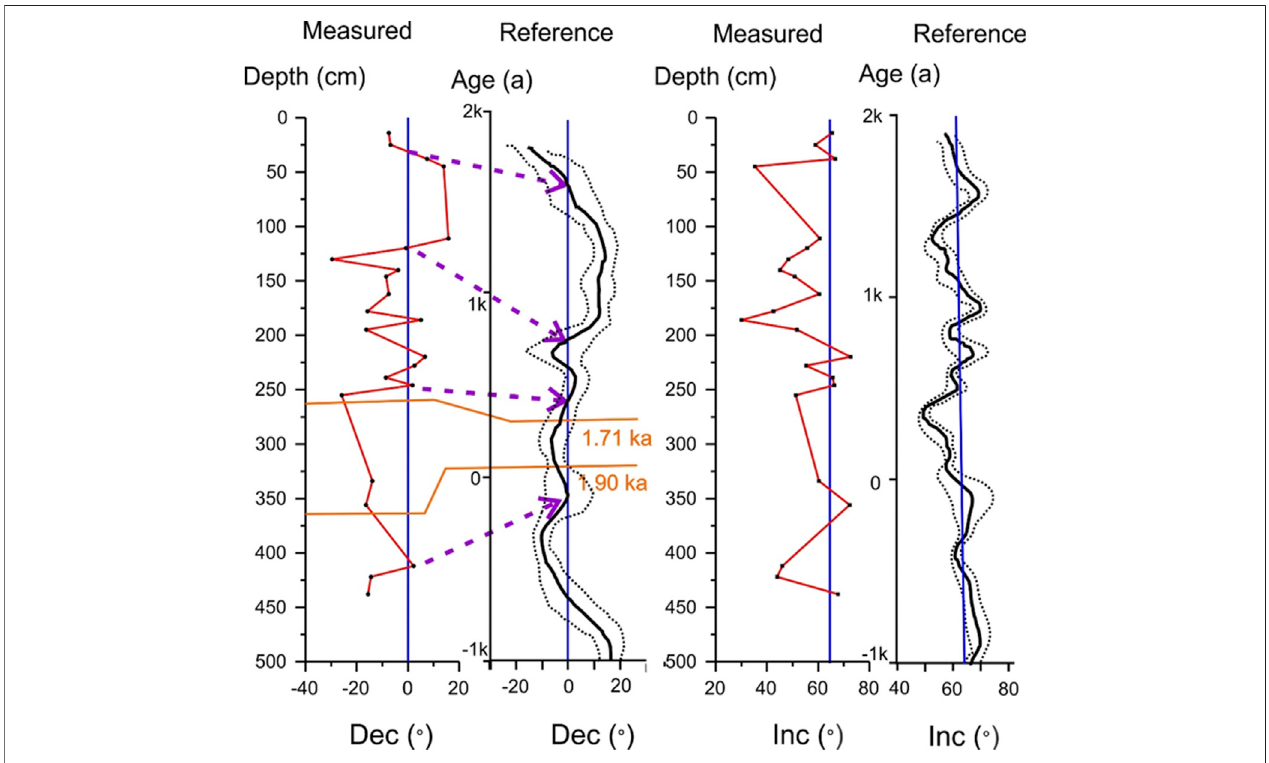
FIGURE 5 | Paleomagnetic dating of sediments in the Zaton3 section using the correlation of the measured declinations and inclinations (Dec; Inc.; red lines) with the reference paleosecular variation curve for Bulgaria (Kovacheva et al., 2014) based on the Bayesian approach (black line = reference curve; dotted lines = con fi dence limits). Blue lines mark expected declination and inclination based on the geocentric axial dipole hypothesis. OSL ages are marked with orange lines. Dotted purple lines mark suggested correlation